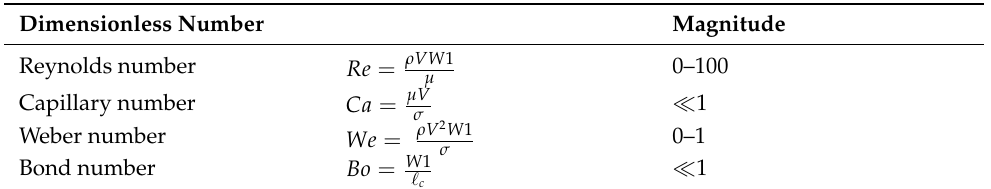
Table 2. The dimensionless numbers and their magnitude. V characteristic velocity, W 1 minimum channel width and (cid:96) c = 2.7 mm the capillary length of water. Dimensionless Number Magnitude Reynolds